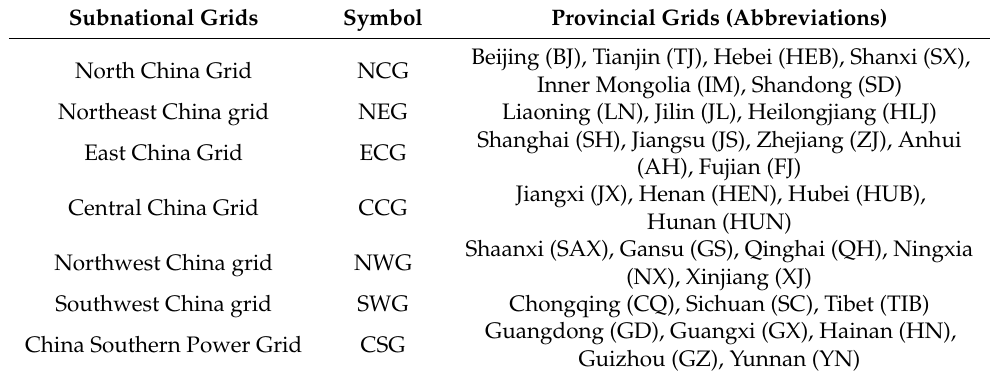
Figure 1. Spatial distribution of subnational power grids and provincial power grids in China. Table 1. Composition of subnational grids.